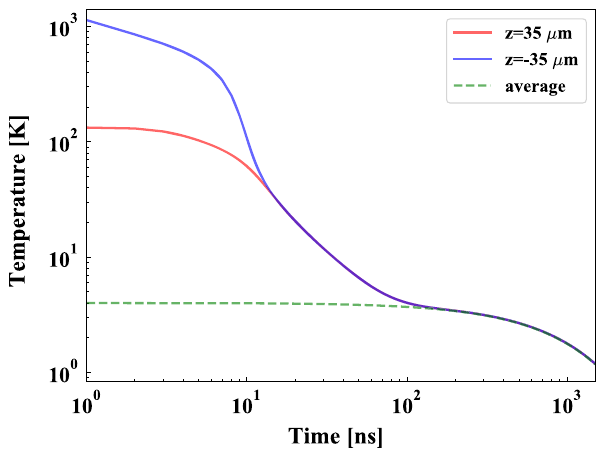
FIG. 9. The temperature (minus 70 K) at the center of the incident surface ( z ¼ 35 μ m) and transmitted surface ( z ¼ − 35 μ m) is shown. The temperature averaged over the whole crystal is presented by a green dash